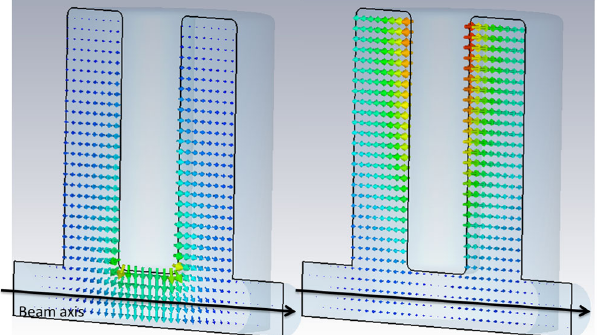
FIG. 11. The distribution of electric field (left) and magnetic field (right) in the deflecting